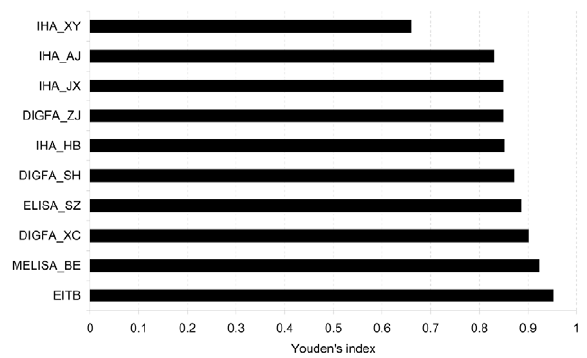
Figure 1. Validity of evaluated tests for the diagnosis of S. japonicum infection (Youden’s index).